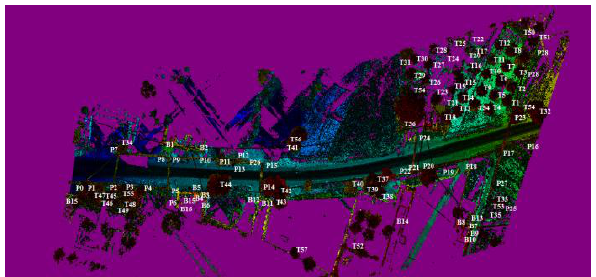
Figure 3. View of MLS data points of study area. PSOs of height 5-7m are visually identified and marked as: P for utility poles and T for trees. Marked PSOs are used as reference data Road environment of the study area is quite complex, because different objects are randomly located without any proper pattern. There is unevenness in distance of two utility poles and their base level from the road surface. Road-side trees are randomly planted. Mostly the utility poles are present in the close proximity of road boundary. Nearly 227 million MLS data points (text file size: 1.22GB) are captured (Figure 3) and average 2D point density of 230 points/m 2 is achieved. Maximum height variation of the ground LiDAR points is